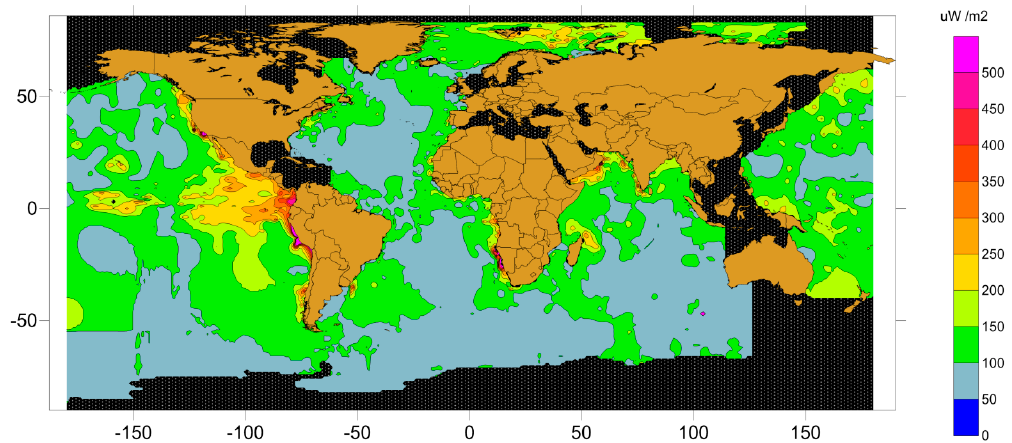
Figure 17. Estimated MFC power output with a 1 m 2 anode at 2 °C.